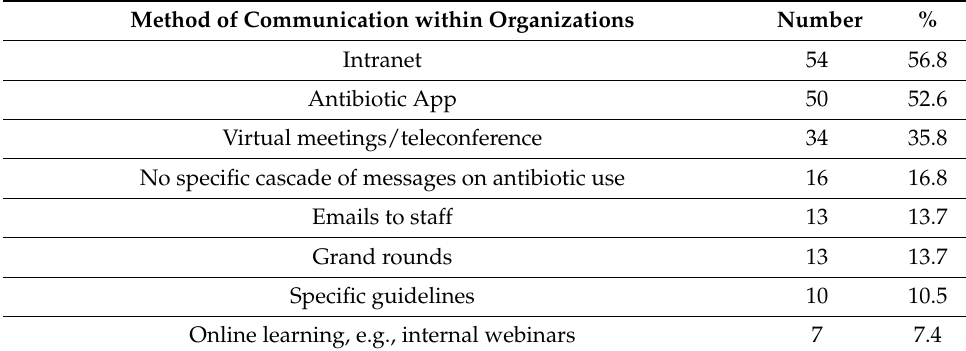
Table 4. Communication methods by organizations during the COVID-19 Pandemic .